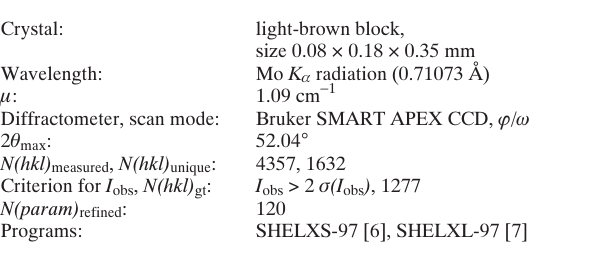
Table 1. Data collection and handling.